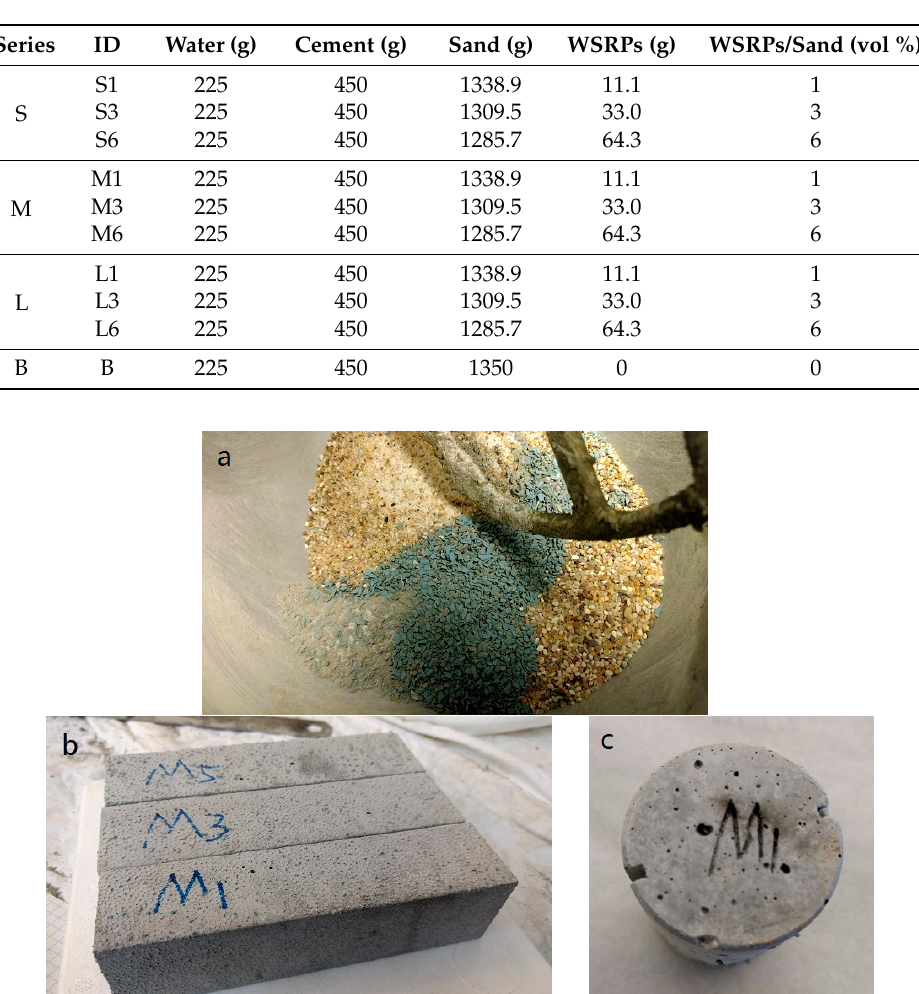
Figure 2. Images of ( a ) the mixture prepared for mixing procedure; ( b ) prisms for mechanical test and ( c ) cylinder with double notches for water permeability test.